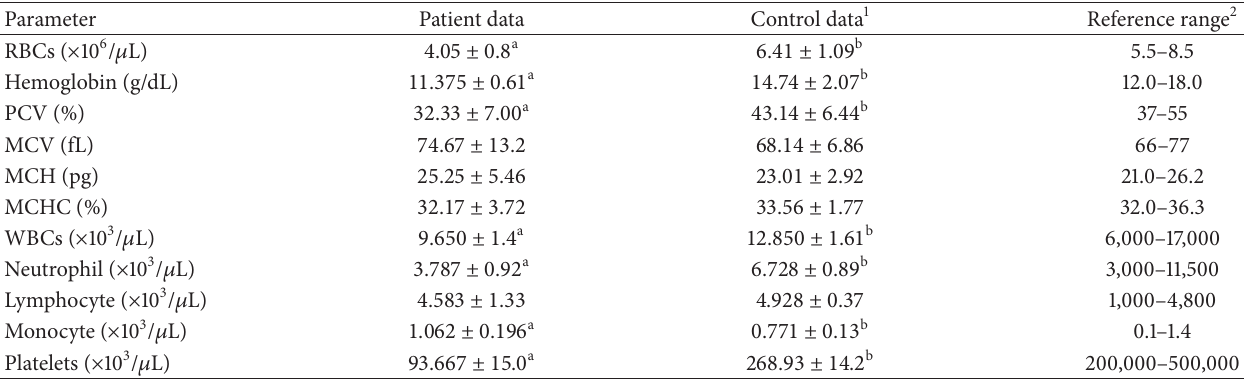
Table 3: Hematologic findings of 13 dogs with babesiosis from small animal internal medicine teaching hospital, faculty of veterinary medicine, Cairo University.